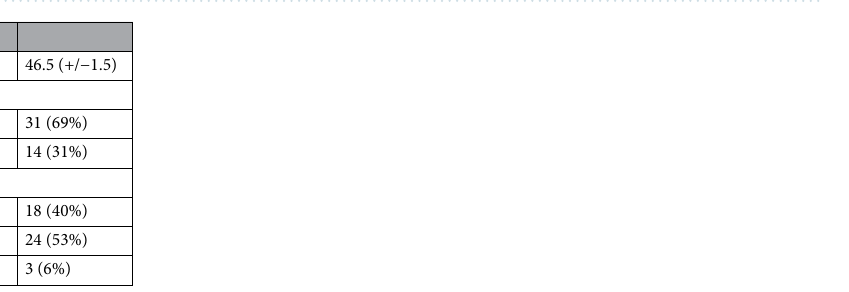
Figure 1. Absolute and age-adjusted (aa) telomere length (TL) in peripheral blood before bariatric surgery. Absolute TL in ( A ) lymphocytes (blue dots; n = 45) and ( B ) granulocytes (yellow dots; n = 43) in patients with obesity before bariatric surgery given in kilobases (kb). The TL of healthy subjects (n = 105) was used to show the 1%, 10%, 50%, 90% and 99% percentile of the TL, respectively (black lines). ( C ) Lymphocytes (blue dots; n = 45) show a mean aaTL of -0.37 kb ( P = 0.0446) compared to the healthy control population. Granulocytes (yellow dots; n = 43) show a mean aaTL of 0.28 kb ( P = 0.1108) compard to the healthy control population. Data are displayed as mean (red bar). *Significance of P < 0.05, ** P < 0.01 (Student’s t-test).